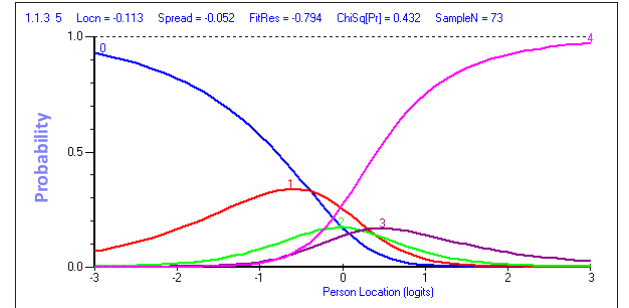
FIGURE 11: Initial category probability curve for Item 1.1.3.